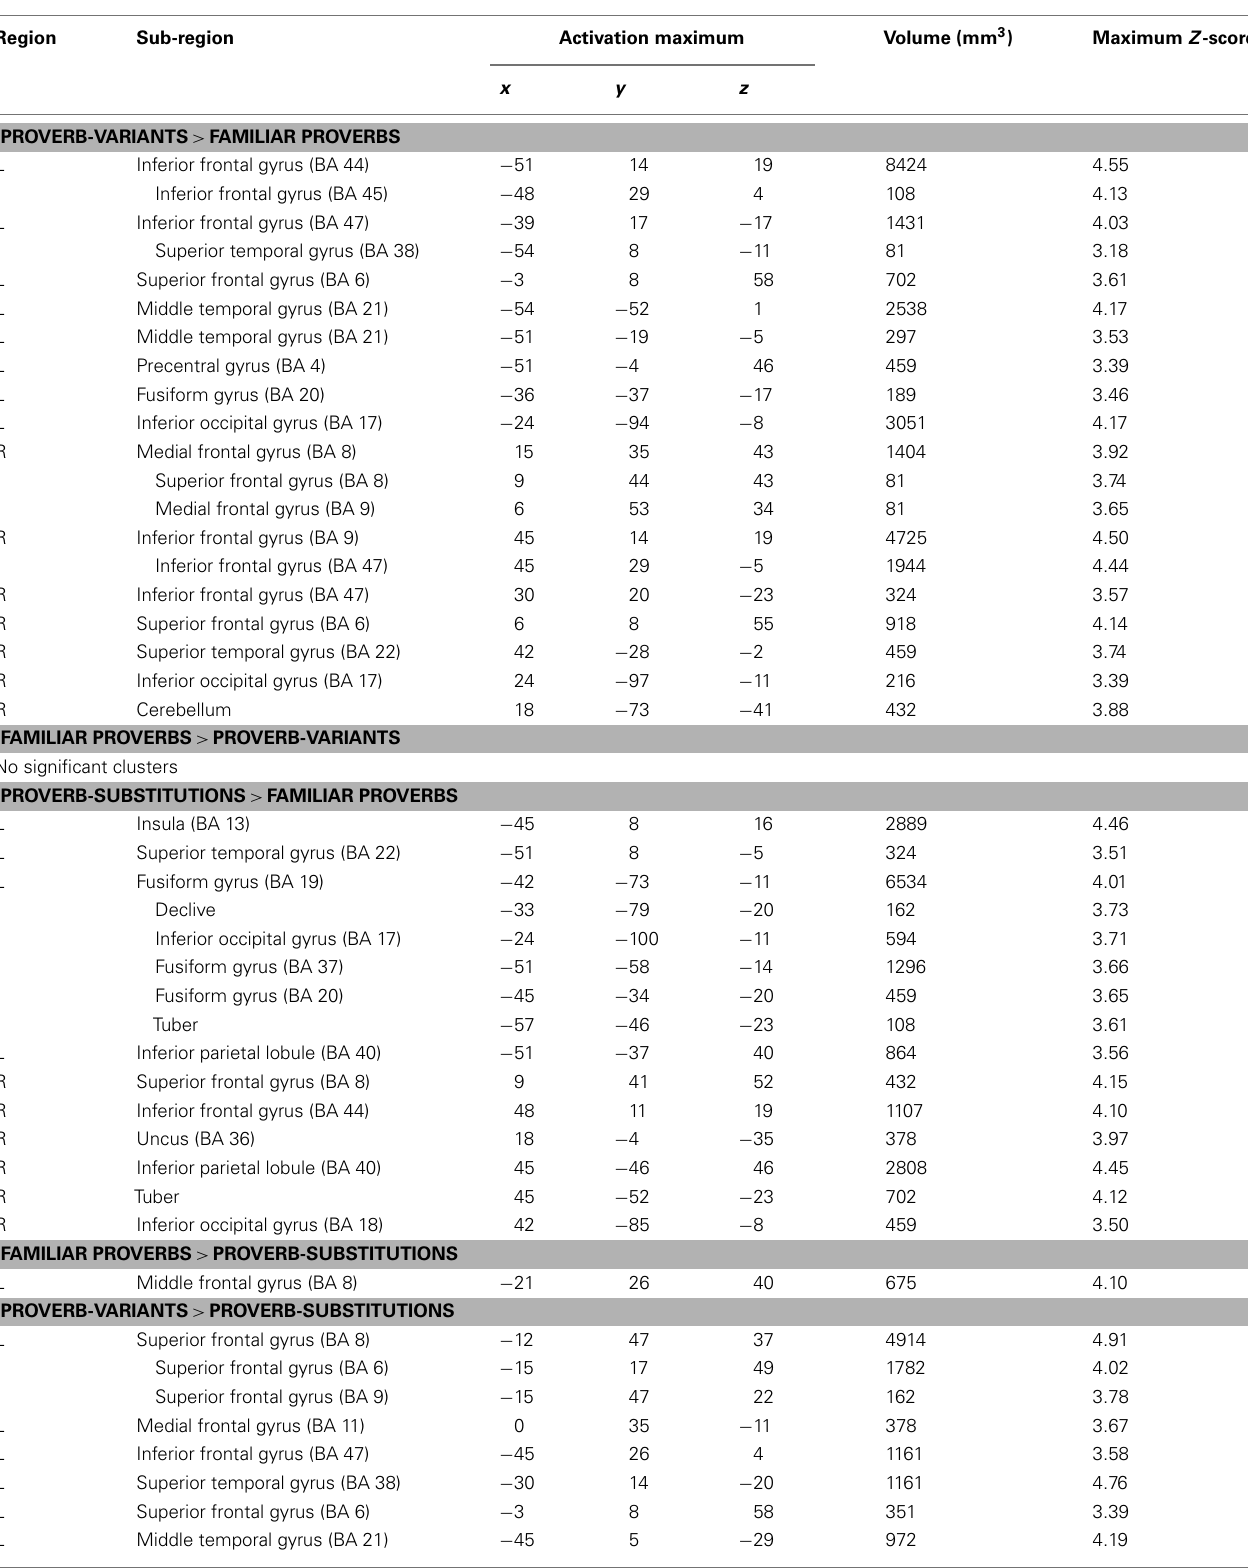
TableA2 | Effects of